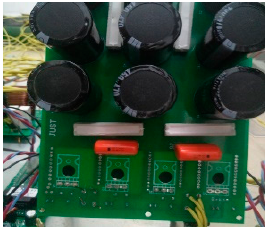
Figure 14. Front of the main circuit in the PAPF.